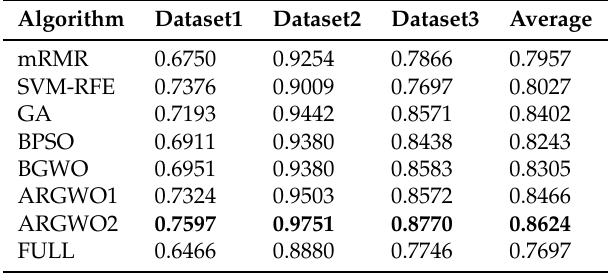
Table 8. F1-score comparison of various